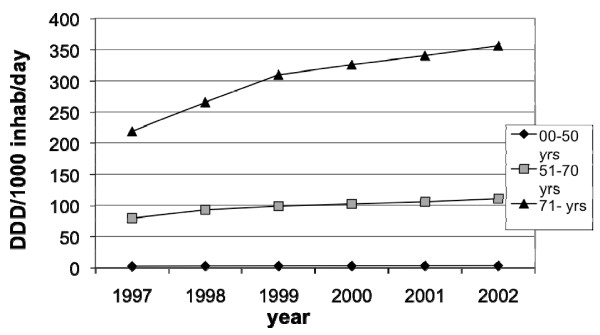
Sales of prescribed low-dose ASA between 1997–2002 in Sweden among males.